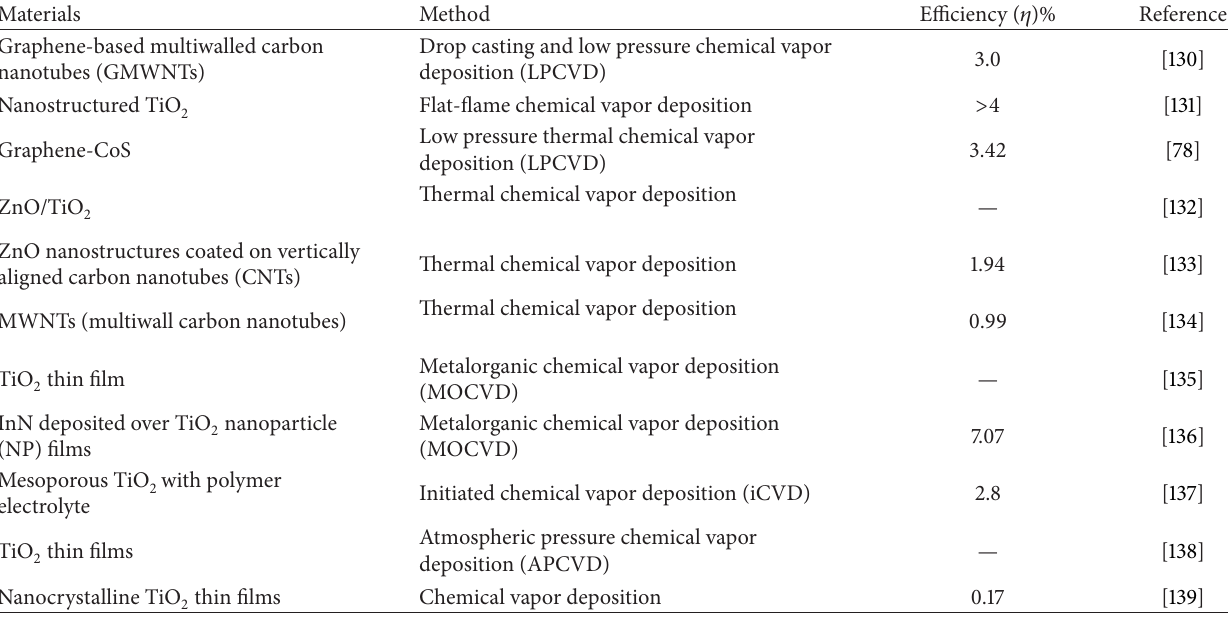
Table 1: Some research results on DSSC using different CVD methods.